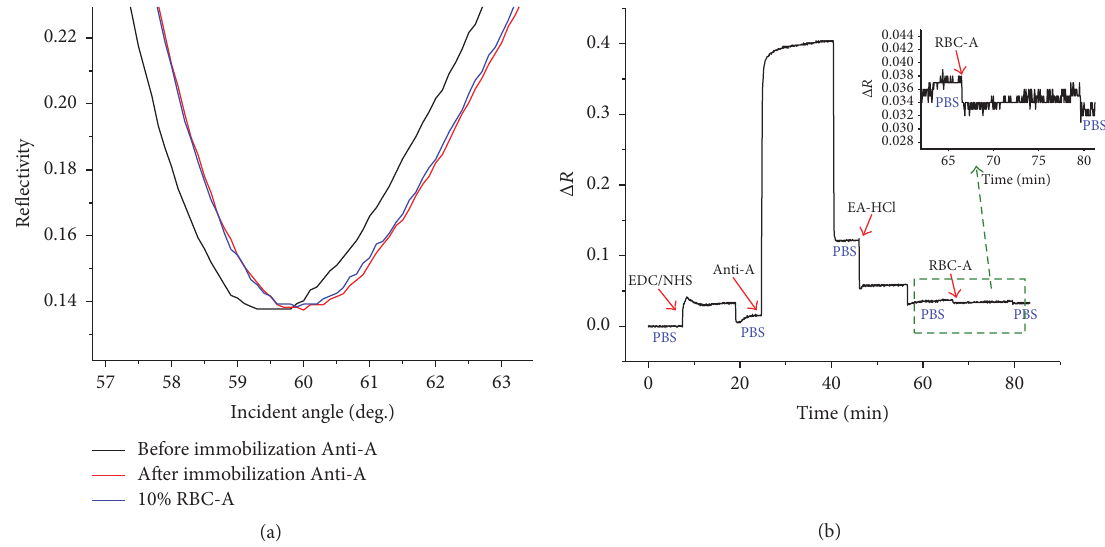
Figure 3: (a) Angular reflectivity curves of conventional SPR before and after immobilization and after the detection of RBC-A. (b) Corresponding SPR kinetic reflectivity curve.